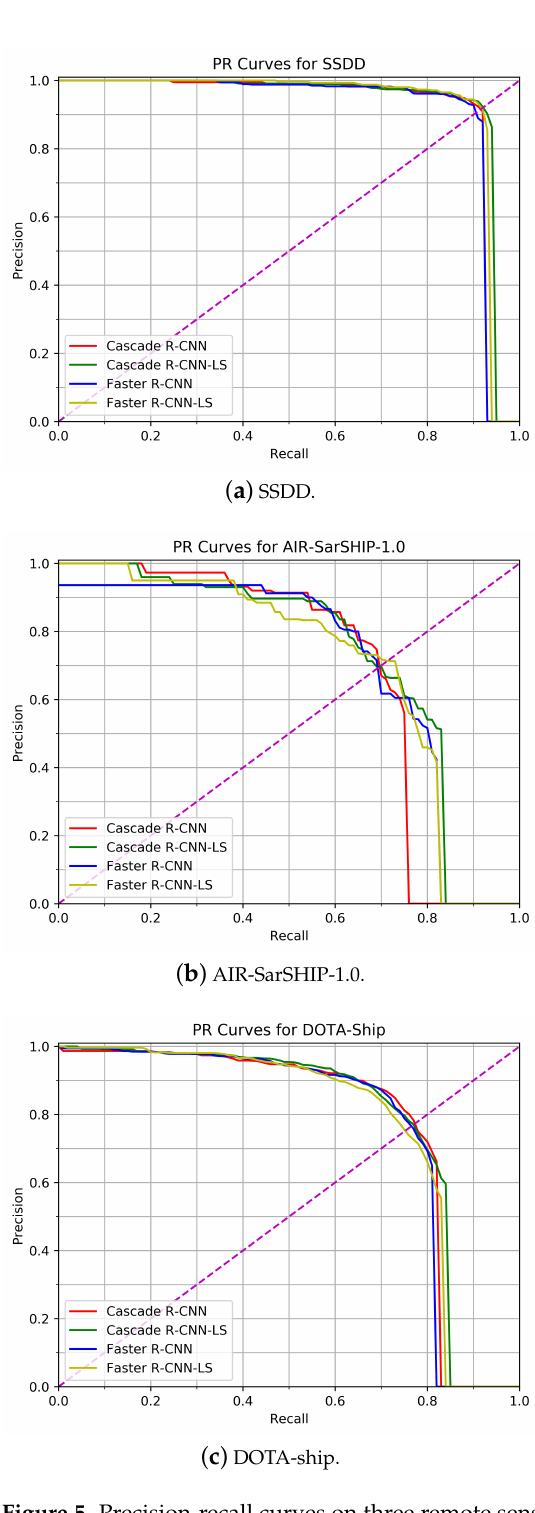
Figure 5. Precision-recall curves on three remote sensing image datasets of two pairs of detection networks, including (1) Cascade R-CNN and Cascade R-CNN-LS, (2) Faster R-CNN and Faster R-CNN-LS. For all the datasets, Cascade R-CNN-LS consistently performs the best, and the lifting scheme-based method is superior to the strided convolution in both experiments with the baselines of Cascade R-CNN and Faster